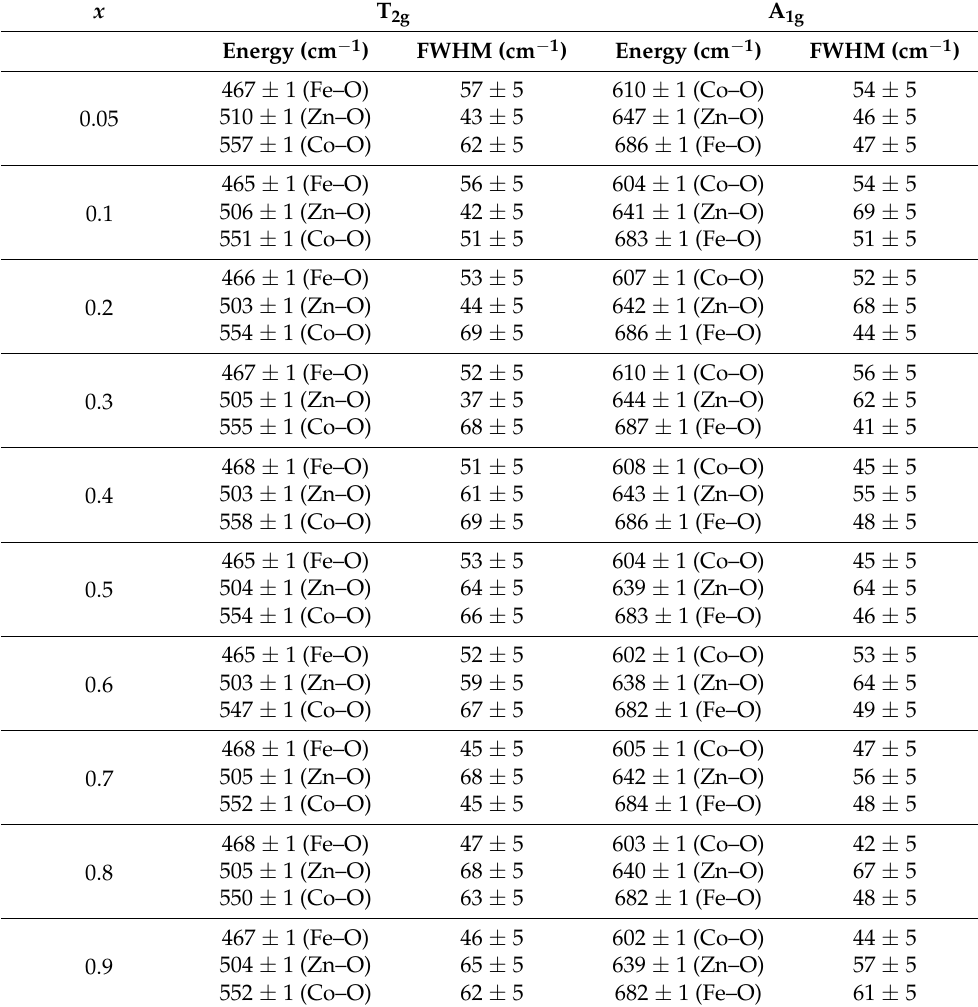
Table 3. Fitting results of the main Raman modes for Co 1 − x Zn x Fe 2 O 4 nanoparticles.